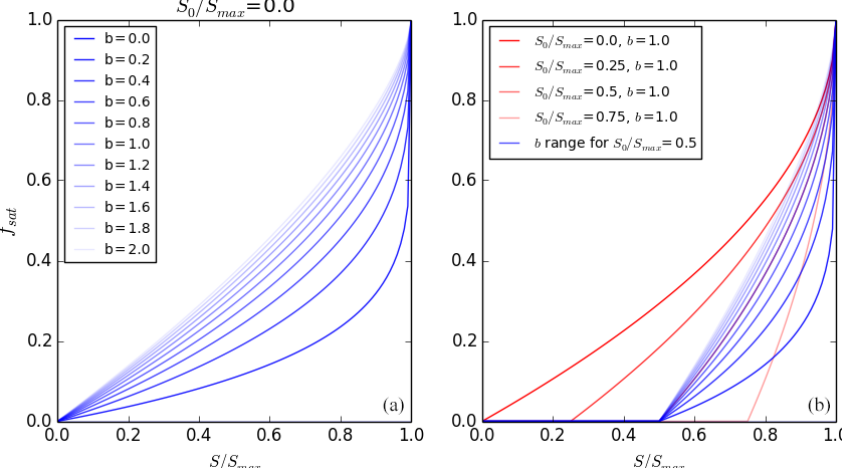
Figure 2. (a) Variability of the soil moisture saturation fraction introduced by the b parameter in the PDM scheme, for S 0 /S max = 0 . 0. (b) Variability of the soil moisture saturation fraction introduced by the S 0 /S max parameter in the PDM scheme, for b = 1 . 0 (red lines) and variability introduced by the b parameter for S 0 /S max = 0 . 5 (blue